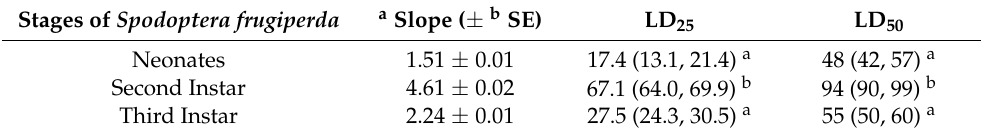
Table 3. Lethal dose (LD), regression slope and fiducial limits (FL) of the rabbit urine needed to reduce the damage of the fall armyworm ( Spodoptera frugiperda ) larval stages feeding on maize treated by 25 and